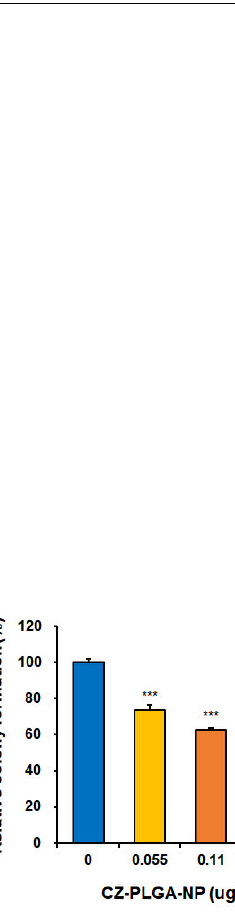
Figure 6. Effects of CZ-PLGA-NPs on in vitro metastatic traits and downstream activation of AKT and ERK in Renca-SRLu5-Luc cells. ( A ) Statistical analysis of the cell colony formation rate in CZ- PLGA-NPs-treated Renca-SRLu5-Luc cells; ( B , C ) Statistical analysis of the results from the migration assay ( B ) and the invasion assay ( C ) in CZ-PLGA-NPs-treated Renca-SRLu5-Luc cells; ( D ) Effects of CZ-PLGA-NPs on ERK and AKT signaling molecules in Renca-SRLu5-Luc cells. Renca-SRLu5-Luc cell lysates were isolated at 10 min or 24 h after exposure to indicated concentrations of CZ-PLGA- NPs, and then the protein levels of phosphorylated and dephosphorylated ERK and AKT were analyzed using Western blotting. β -actin was used as a loading control. Each point represents the mean ± SD of three independent experiments. *** p <